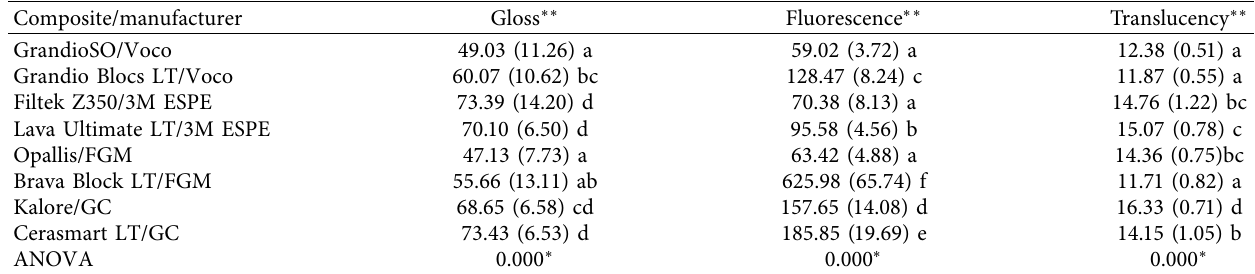
Table 2: Mean values (SD) and results of Tukey’s test considering the absolute values of gloss, fluorescence, and translucency before staining.